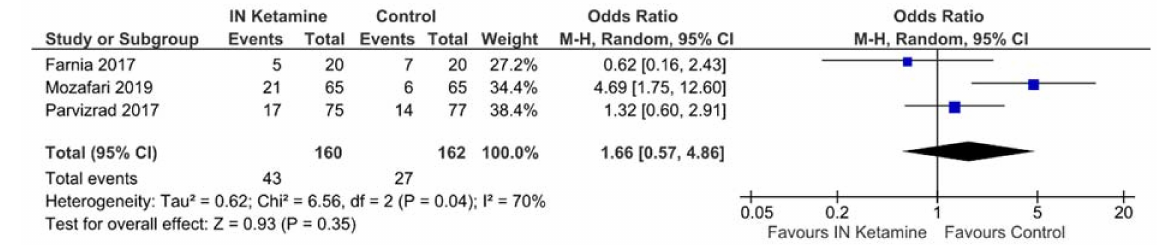
Figure 3. The need for rescue analgesics.